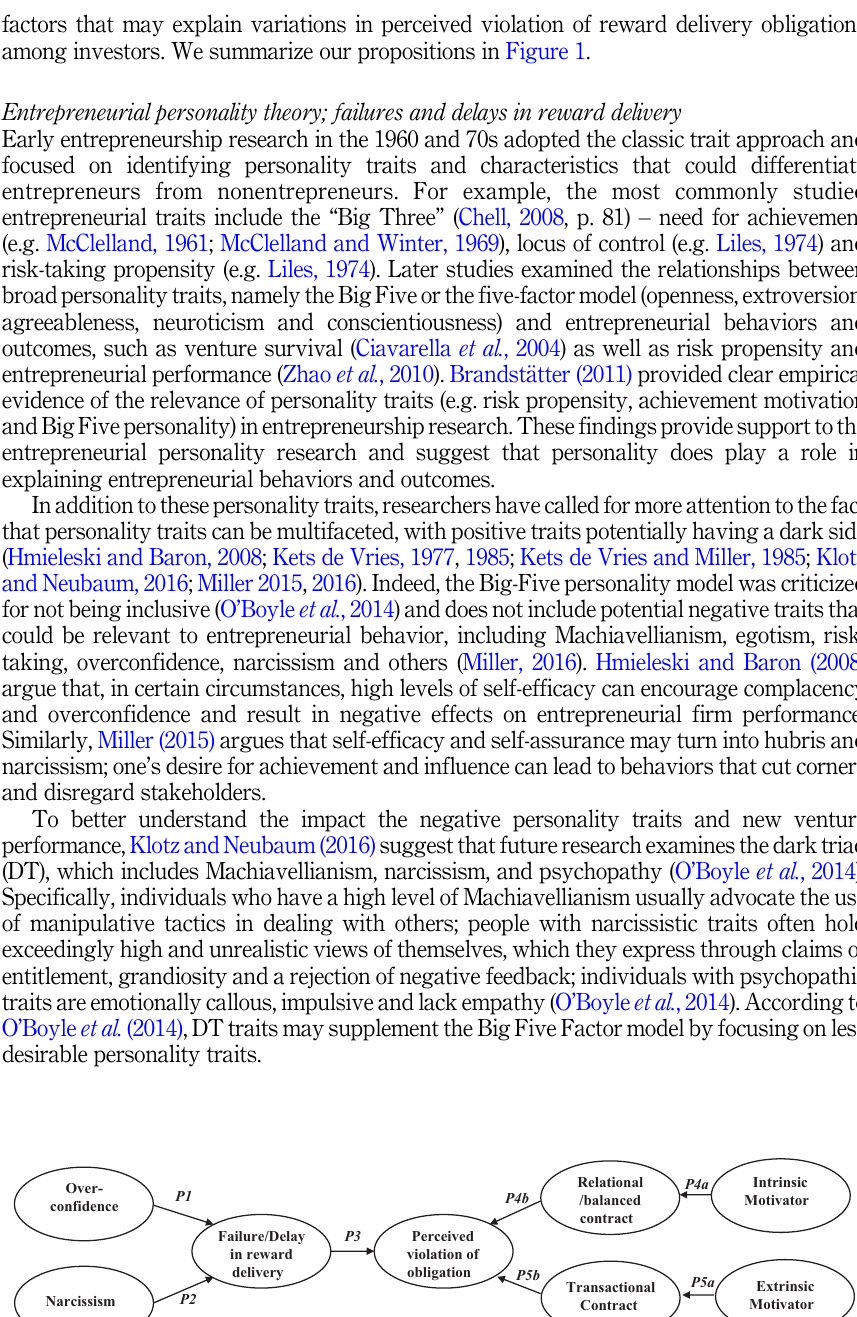
Figure 1. A conceptual framework of factors related to perceived violations of reward obligations in the RBC